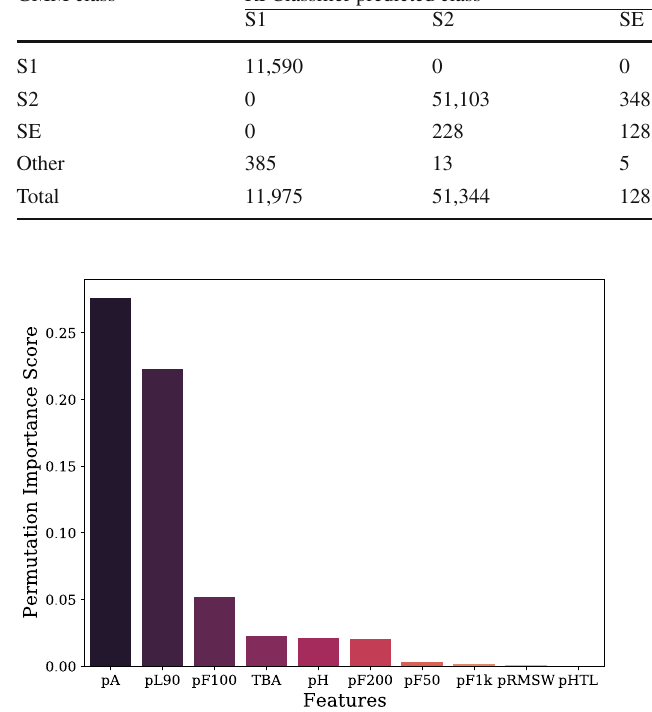
Fig. 6 PermutationimportancerankingobtainedwiththeRFClassifier